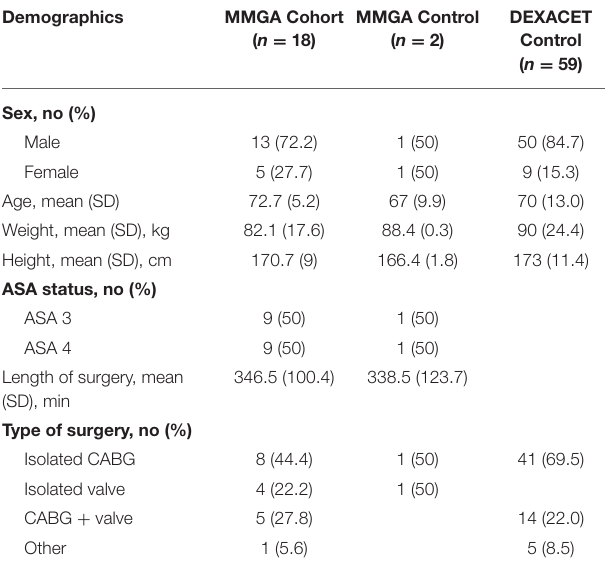
FIGURE 3 | Quantification of hemodynamic stability and vasopressor usage during MMGA in comparison to a historical standard-of-care. Little difference was observed between hypotensive AUC (median, [IQR] min’mmHg; MMGA 921.0, [793.1, 1287.2]; historical 995.1, [653.7, 1292.7]; P = 0.72 Mann-Whitney U test), CV (median, [IQR]; MMGA 0.32, [0.28 0.36]; historical 0.34, [0.31, 0.38]; P = 0.14 Mann-Whitney U test), and norepinephrine equivalent dose (median, [IQR] mcg; MMGA 734.5, [526.1, 856.1]; historical 704.77, [336.4 1065.0], P = 0.90 Mann-Whitney U